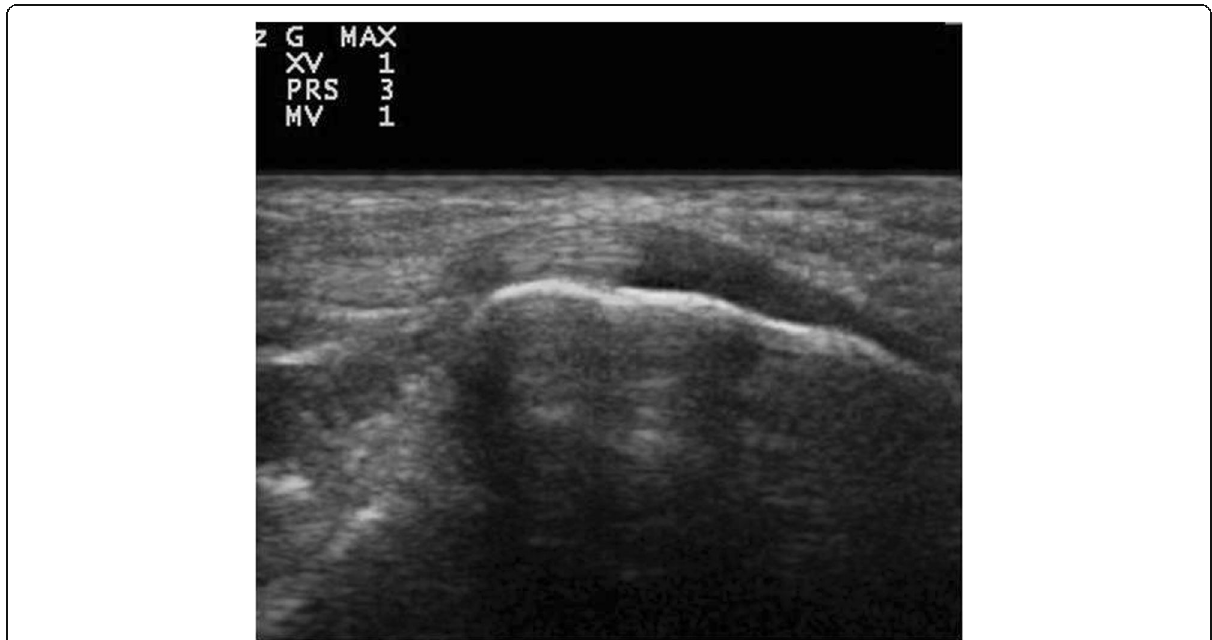
Fig. 7 MSUS of right Achilles tendon of 26 years female RA patient showing calcification at insertion site and loss of fibrillary pattern